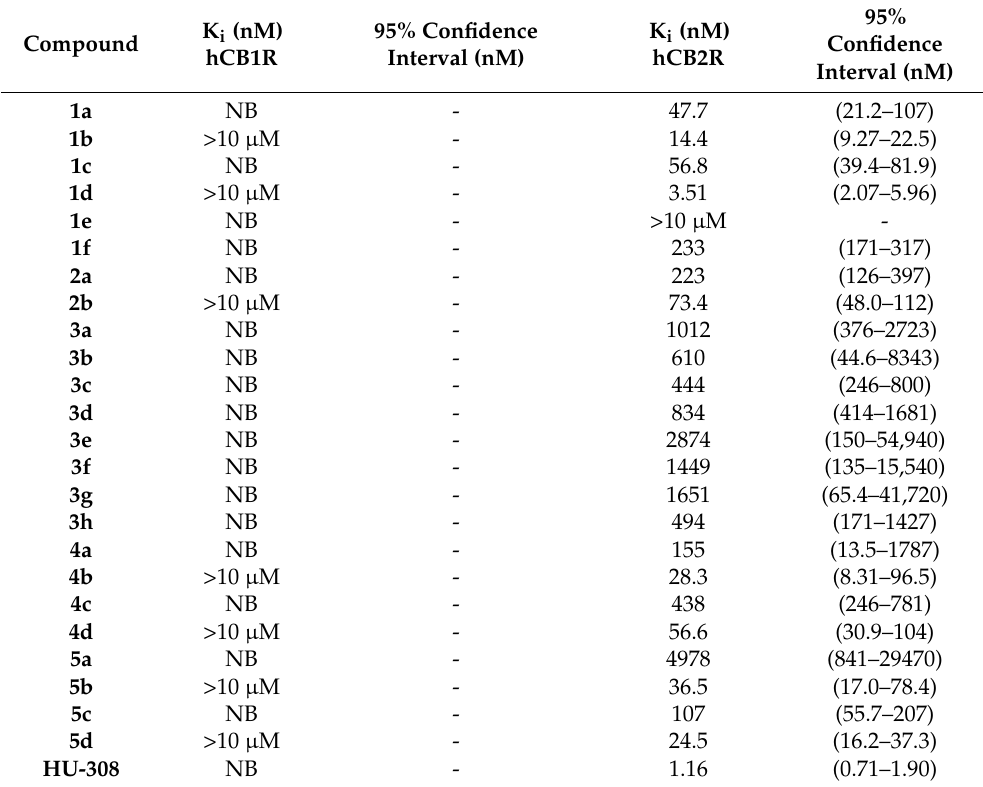
Table 1. Affinities of fenchone derivatives for hCB1R and